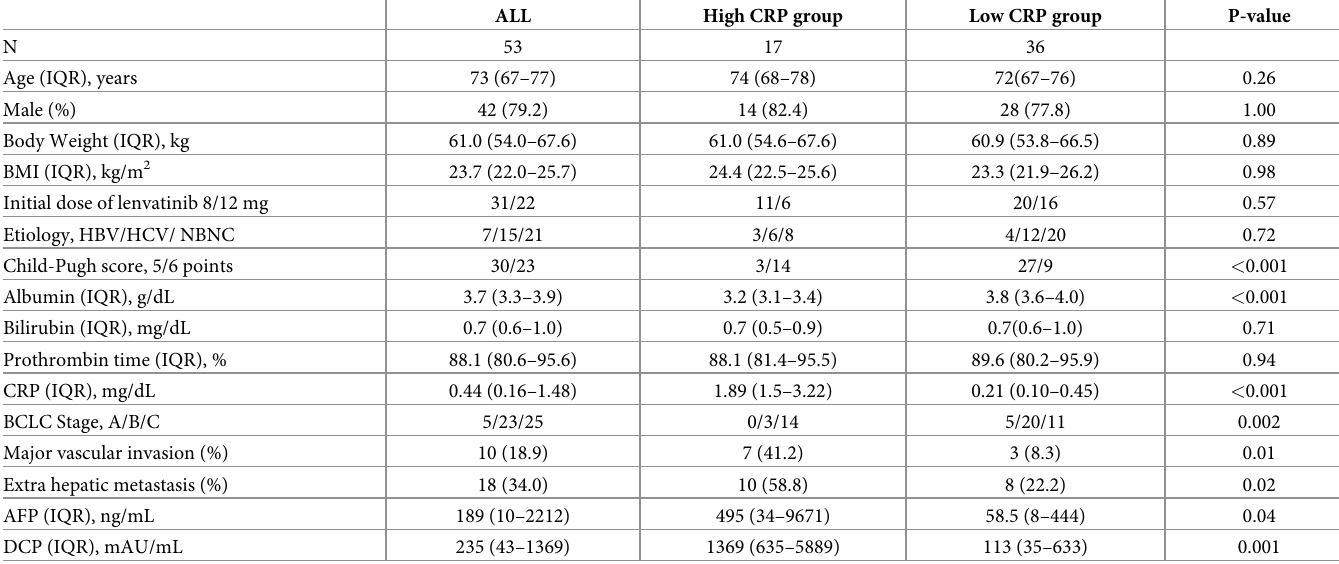
Table 1. Baseline